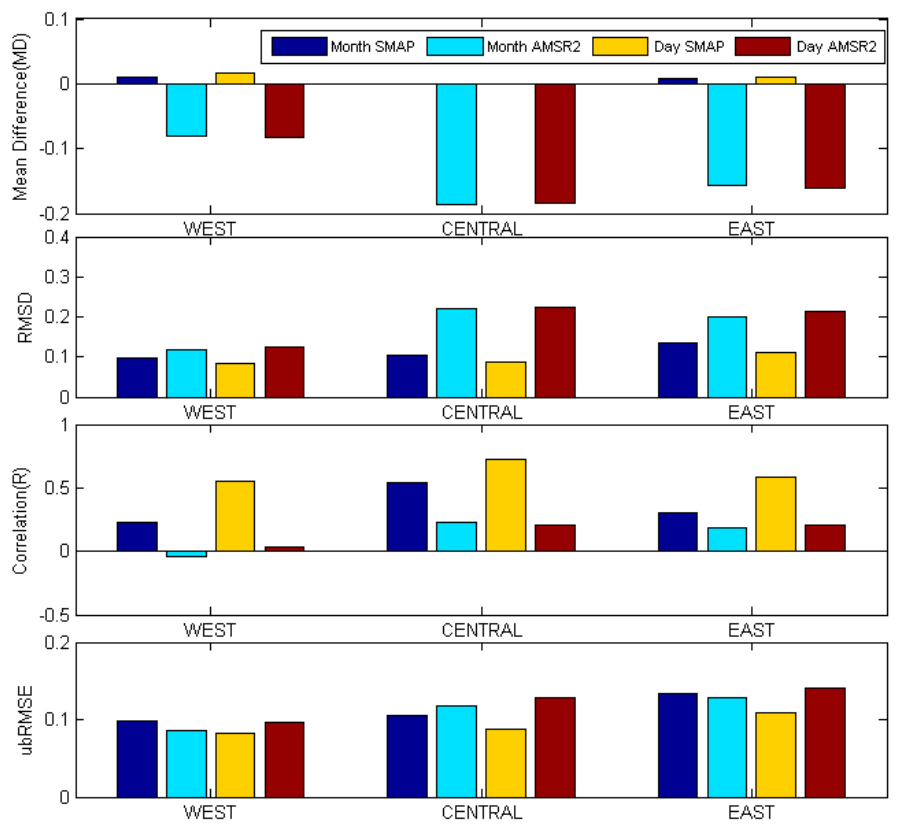
Figure 6. Four statistics results for SMAP L4 SM and AMSR2 L3 SM monthly and daily data in different region of U.S.